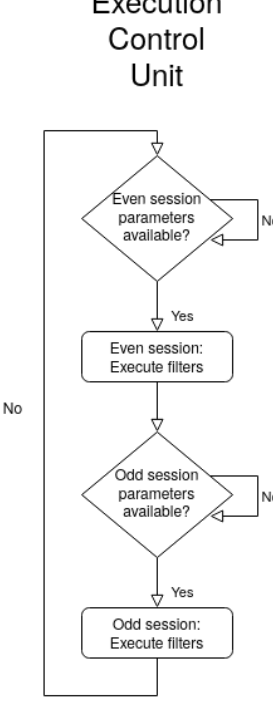
Figure 4. ECG-ID-BNet IP core execution flow.